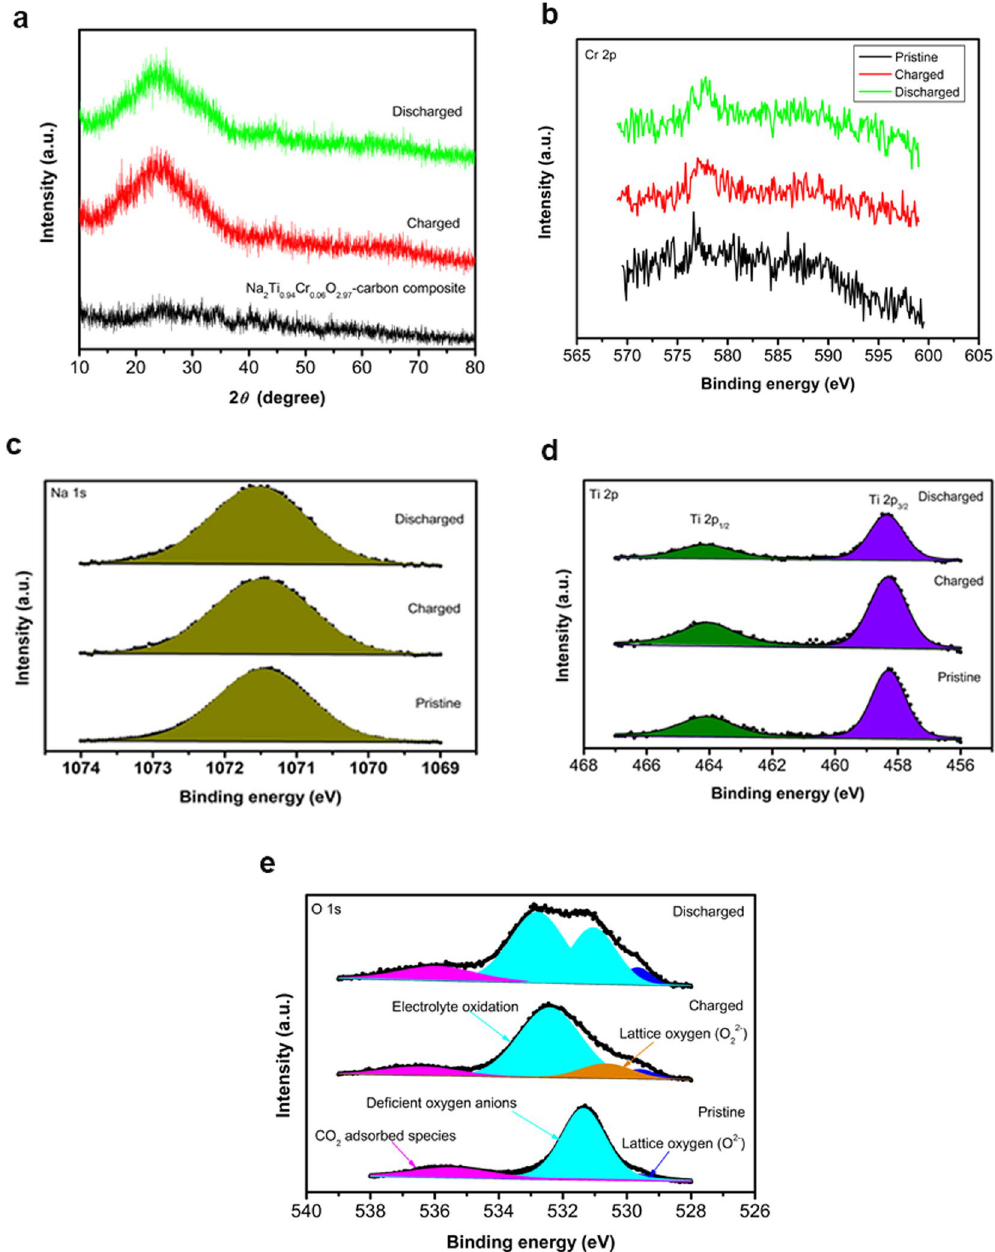
Figure 6. Analysis of the electrochemical desodiation and sodiation of Na 2 Ti 0.94 Cr 0.06 O 2.97 . (a) XRD patterns for the Na for pristine sample, fully charged sample and discharged to 1.5 V as well as by least-squares-fits using a software of XPSPEAK41. ( b) Cr 2p spectra. ( c) Na 1 s spectra. ( d) Ti 2p spectra. (e) O 1 s